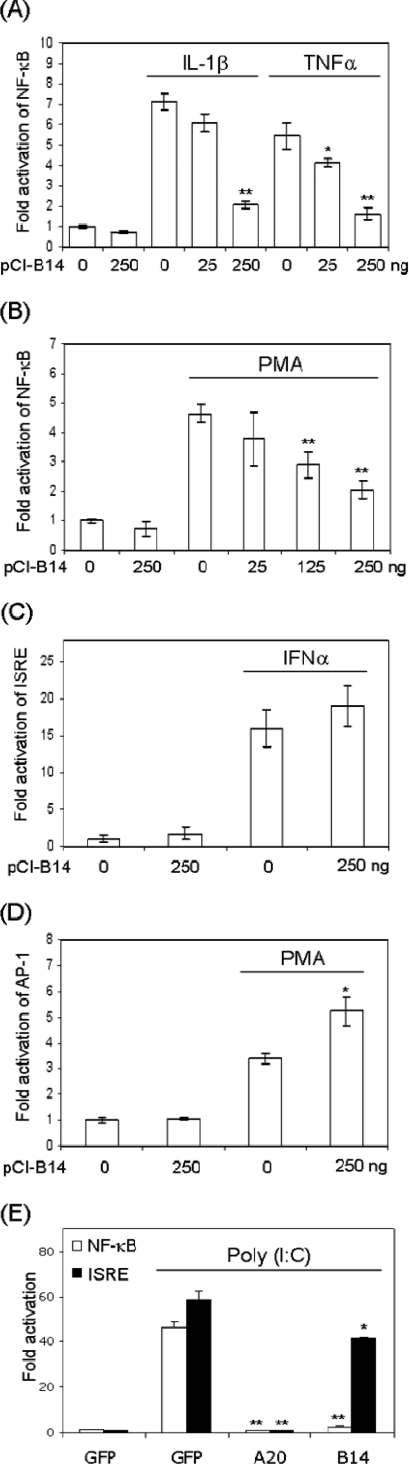
B14 Inhibits NF-κB ActivationHeLa cells were co-transfected with reporter plasmids for 100 ng of NF-κB (A and B), ISRE (C), AP-1 (D), and 50 ng of pSV-β-galactosidase in all cases. pCI-B14 was transfected where indicated and the amount (ng) per well is shown. The total amount of DNA applied in each reaction was adjusted to 400 ng using pCI empty vector. These transfected cells were stimulated with 100 ng/ml of IL-1β, TNFα, IFNα, or 50 ng/ml of PMA for 8 h as indicated. Luciferase activity was measured and normalized to β-galactosidase intensity in the same well in triplicate wells. (E) HEK 293 cells were co-transfected with pRL-TK and reporter plasmid for NF-κB (□), ISRE (▪), and plasmids expressing GFP, A20, and B14. These cells were stimulated with 5 μg/ml of poly(I:C) for 12 h and then were lysed to measure luciferase activity using Dual-specific luciferase assay kit (Promega). Differences in the fold activation of the indicated reporter in cells transfected with the empty vector and cells expressing B14 were analysed by Student's t-test and the p-values are indicated: * p < 0.05 or ** p < 0.01.